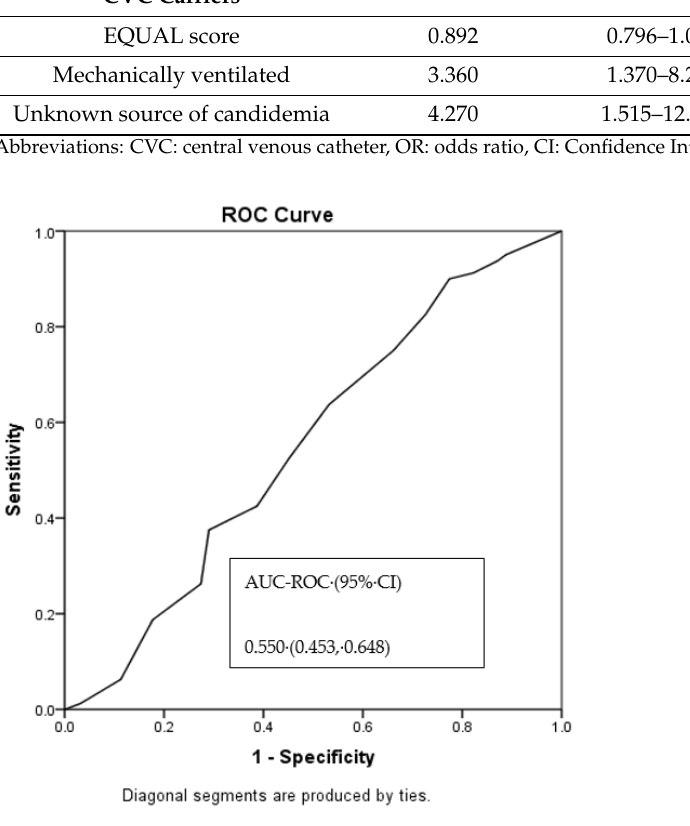
Figure 2. AUC-ROC Curve Analysis for the multivariable logistic regression model, including the total population. Abbreviations: CI, confidence interval; AUC-ROC, area under the curve-receiver operating characteristic.